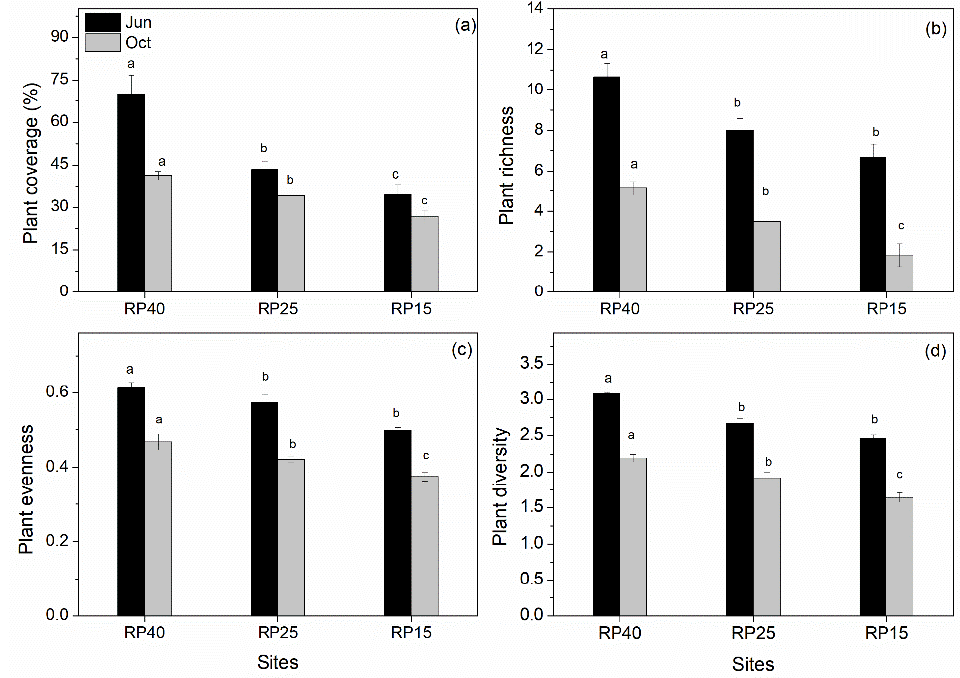
Figure 2. Plant community characteristics (( a ) plant coverage, ( b ) plant richness, ( c ) plant evenness, ( d ) plant diversity) after afforestation. Different letters denote significant ( p < 0.05) differences among sites in same month; error bar represents standard error. Note: 40, 25, and 15 years of Robinia pseudoacacia L. indicated as RP40, RP25, and RP15.